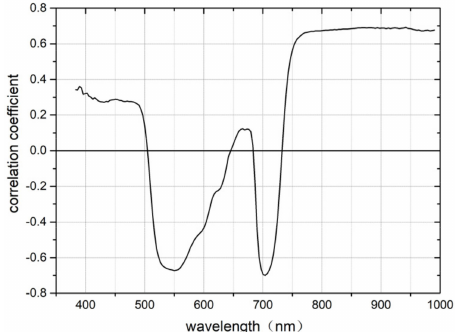
Figure 6. Correlation of SPAD values and spectral reflectance.